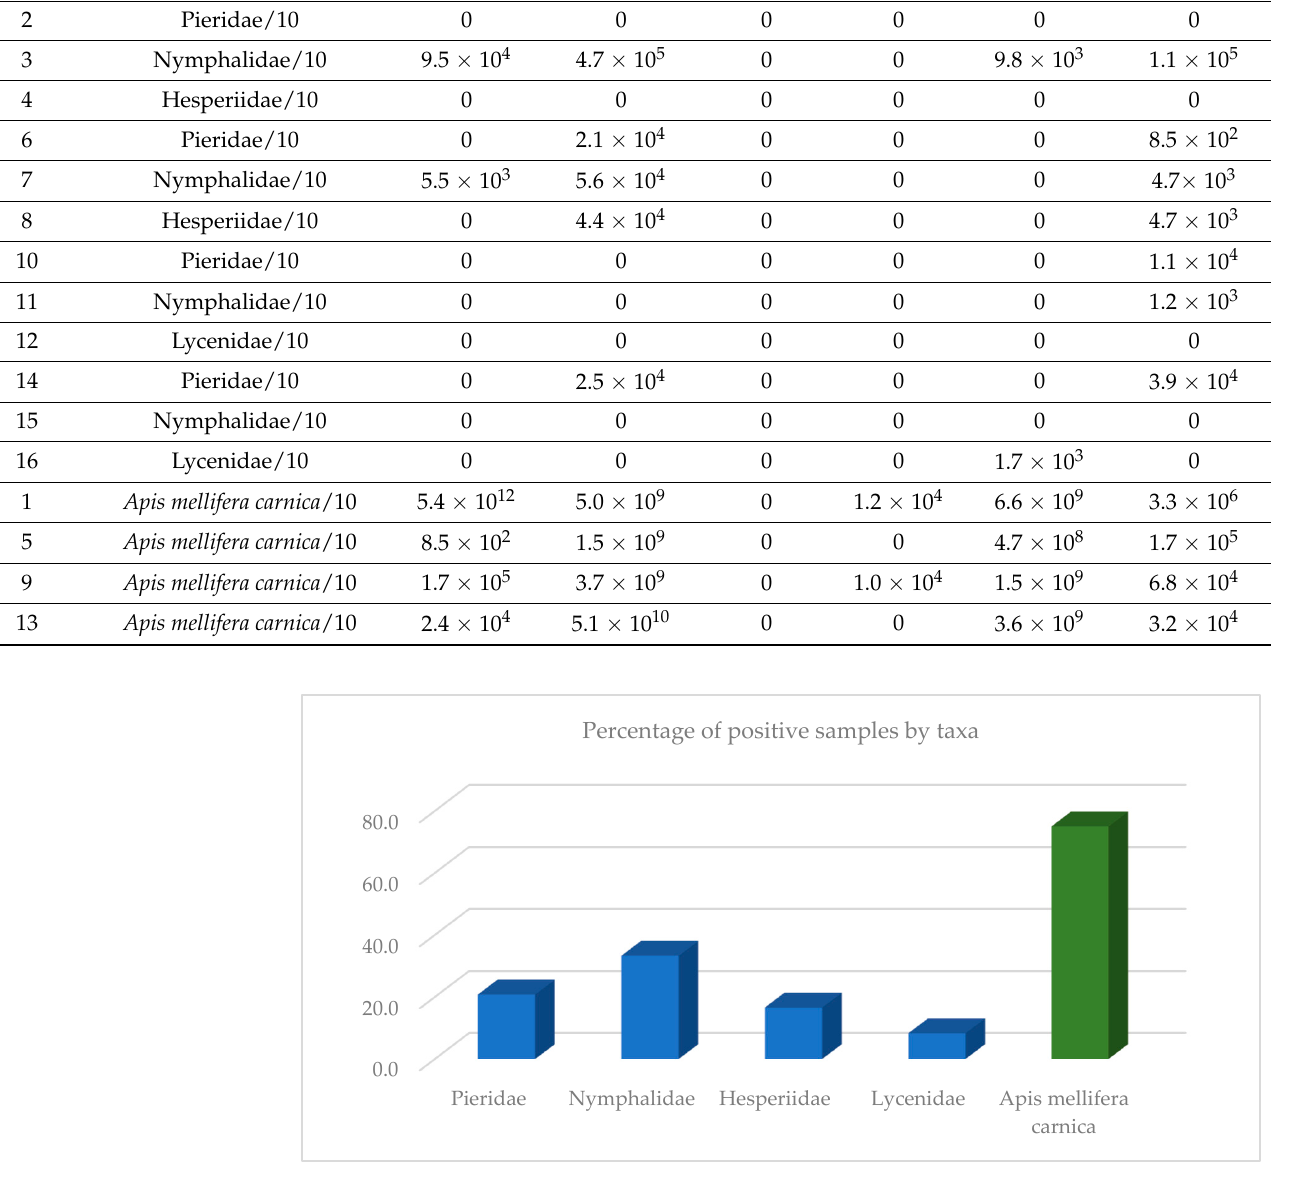
Figure 1. Percentage of positive samples detected in butterflies in comparison to honeybee samples.